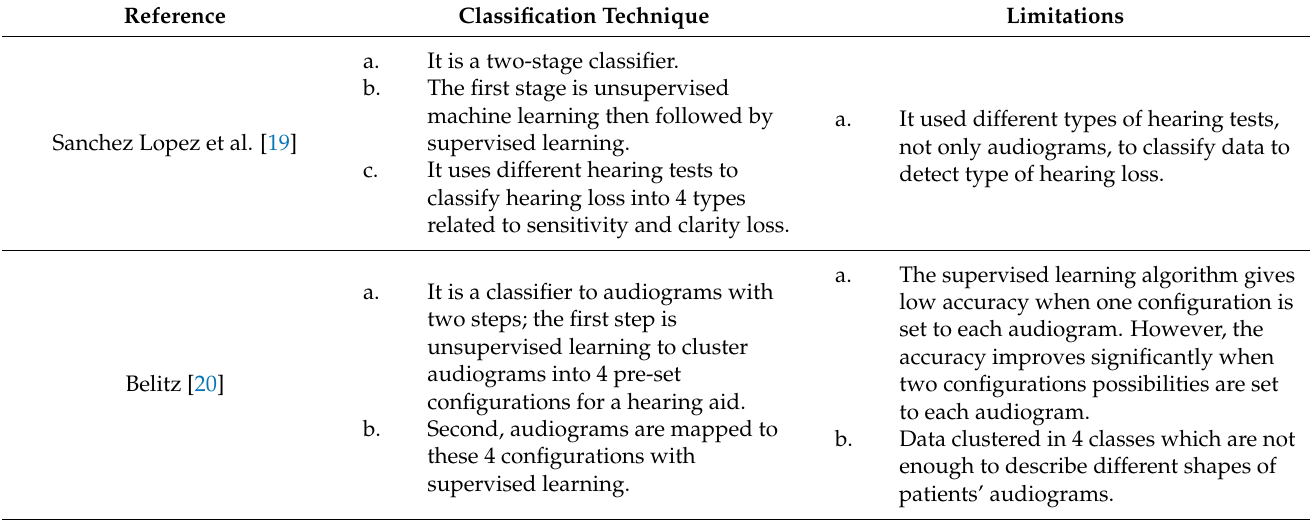
Table 1. Summary of audiogram